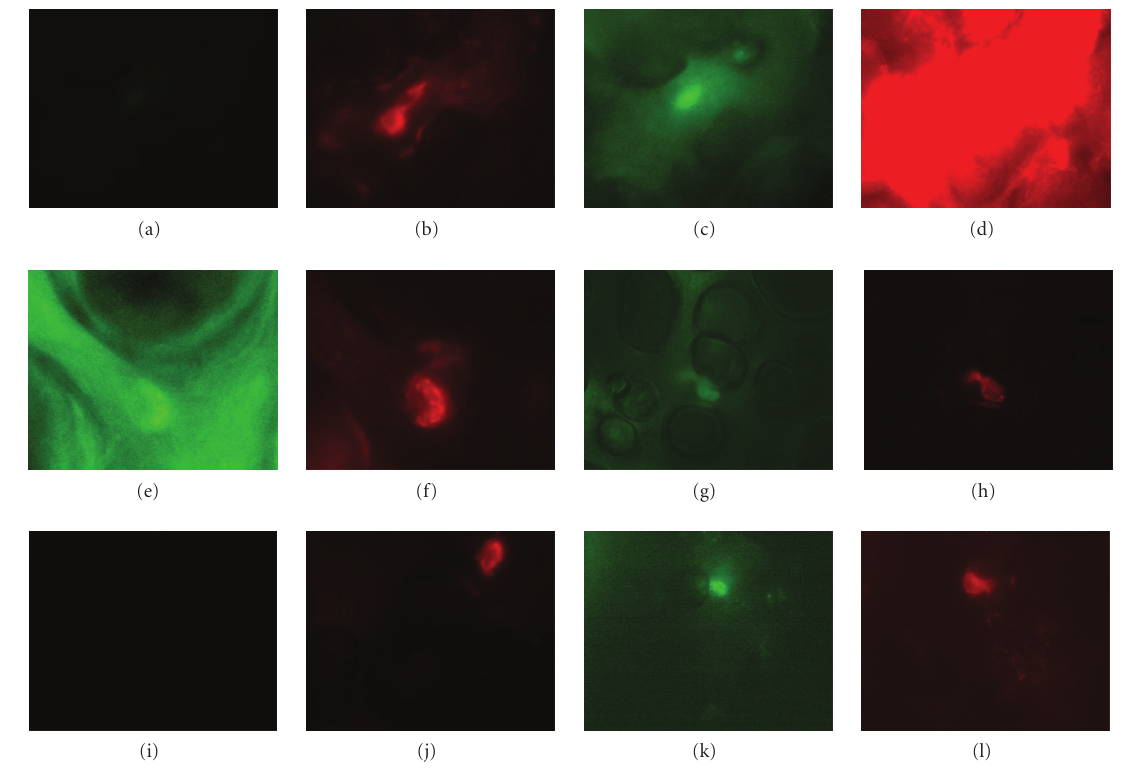
Figure 2: Increased depth of imaging by using far-red and near-IR probes compared with GFP. 4T1-GFP cells labeled with PTIR271–274 probes were administered in the perfusate of isolated rat lungs or administered in the tail vein followed by lung isolation and intact lung transpleural imaging. (a) represents GFP picture (Ex/Em 480/510; exposure 0.5s; depth from lung surface 35 μ m; (b) represents the same area with PTIR271 picture (Ex/Em 640/680; exposure 0.5 s). (c) and (d) represent same area as in (a) and (b), respectively, but with exposure time of 2 seconds to show the presence of cells in the GFP channel. (e) represents intravascular localization of tumor cell in the GFP channel 5 days after intravenous injection. The vascular outline is visible due to autofluorescence. Exposure time is 2 seconds. Imaging depth is 30 μ m. (f) represents PTIR271 channel picture of the same area as in (e); exposure time is 0.5 second. (g) and (h) represent pictures in the GFP and PTIR272 channels, respectively. Exposure time is 2 seconds for GFP; 0.5 second for PTIR272. Imaging depth is 30 μ m. (i) and (j) represent pictures in the GFP and PTIR273 channels, respectively. Exposure time is 2seconds for GFP; 0.5second for PTIR273. Imaging depth is 35 μ m. (k) and (l) represent pictures in the GFP and PTIR274 channels, respectively. Exposure time is 2seconds for GFP; 0.5second for PTIR274. Imaging depth is 33 μ